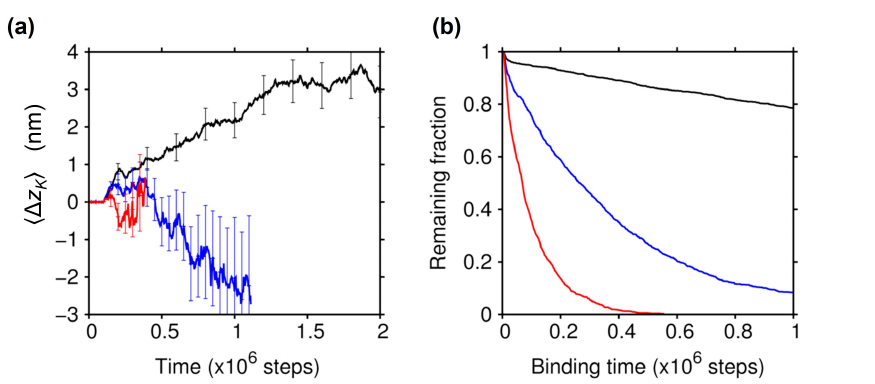
Figure 4. Effect of the Debye screening on biased Brownian motion. ( a ) The results of (cid:104) ∆ z K ( t ) (cid:105) obtained by binding simulations with stronger electrostatic screenings of λ = 0.78 nm (blue) and λ = 0.67 nm (red). The average time course was terminated at the point where the number of KIF1A bound to the MT became less than 100. Error bars indicate the statistical uncertainty at the 68% confidence interval. For comparison, (cid:104) ∆ z K ( t ) (cid:105) for λ = 0.95 nm (the same result as in Figure 2c) is displayed (black). ( b ) The fraction of KIF1A that remained bound to the MT is shown as a function of the binding time for λ = 0.95 nm (black), λ = 0.78 nm (blue), and λ = 0.67 nm